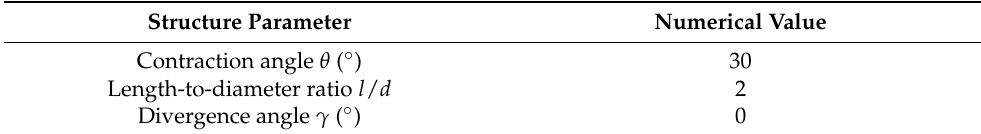
Table 2. Structure parameter of the nozzle.